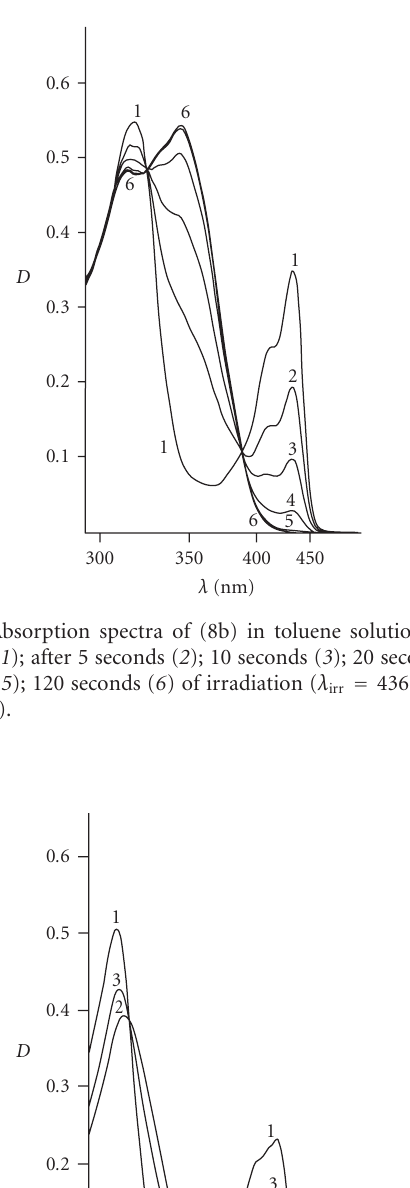
through a toluene solution of form B results in complete restoration of the initial absorption and emission spectra of form A (“o ff